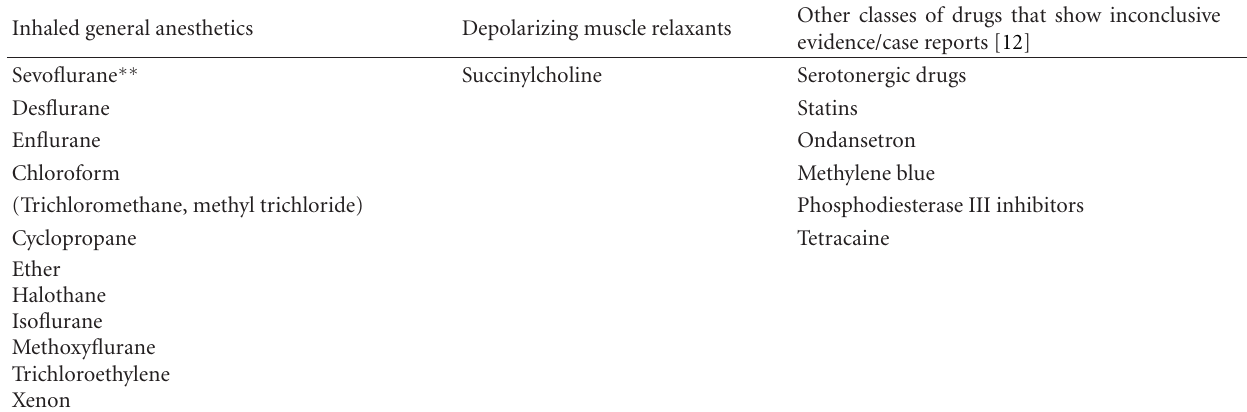
Table 2: Groups of drugs noted to cause or associated with malignant hyperthermia [10,